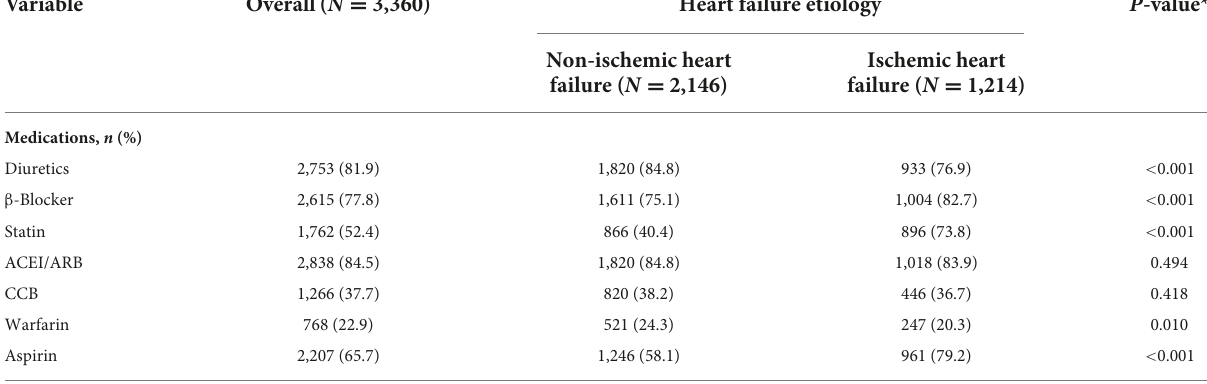
dyslipidemia, diabetes mellitus (DM), but a higher rate of atrial fibrillation (AF), compared with the ischemic subgroup. As for cardiac medications, patients with ischemic HF received more β -blocker, statin, and aspirin therapy than those with non- ischemic HF. Patients with non-ischemic HF received more warfarin therapy, in coincidence with the higher prevalence of AF in this